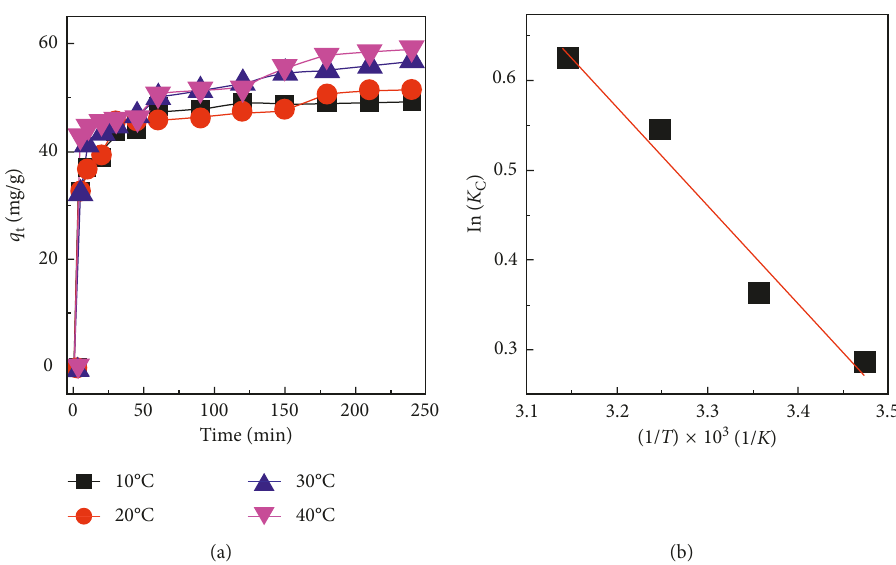
Figure 12: Effect of temperature on adsorption of CR over EG@MnFe 2 O 4 (a) and thermodynamic study (b). Experimental conditions included solution volume of 100mL at pH 4 for MnFe 2 O 4 and pH 6 for EG@MnFe 2 O 4 . Experiments were run at various temperatures (10–40 ° C). Table 5: Thermodynamic parameters for the adsorption of CR over EG@MnFe 2 O 4 . van’t Hoff